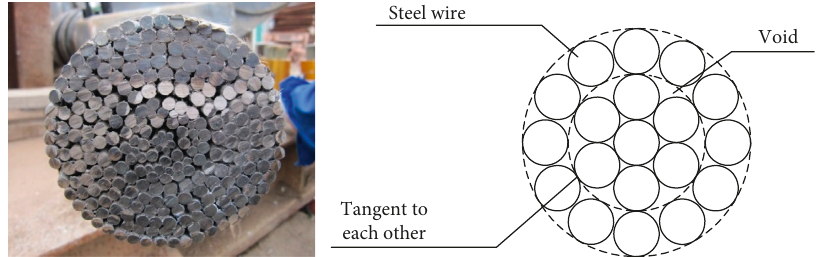
Figure 6: Cross section of a spiral